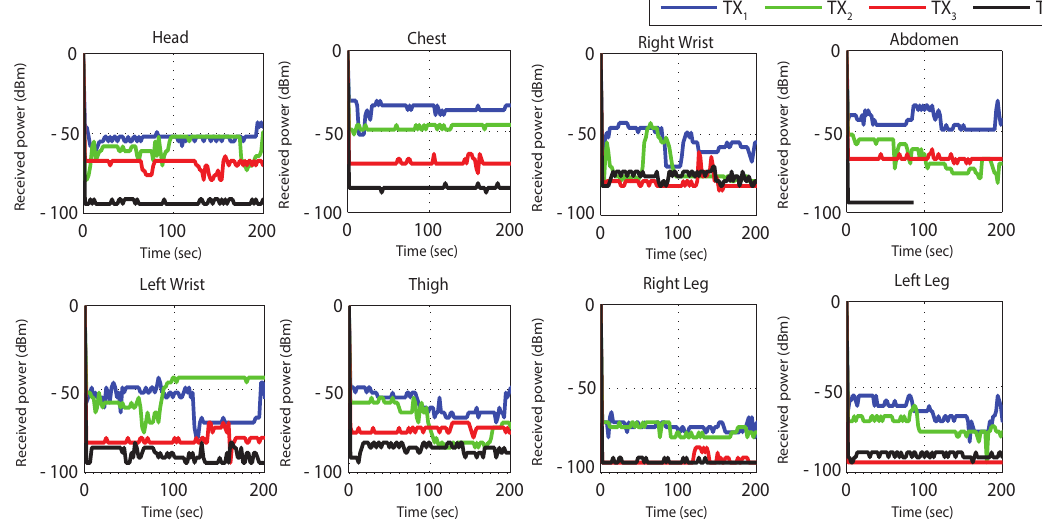
Figure 24. RX power based on default TX power while sleeping activity.